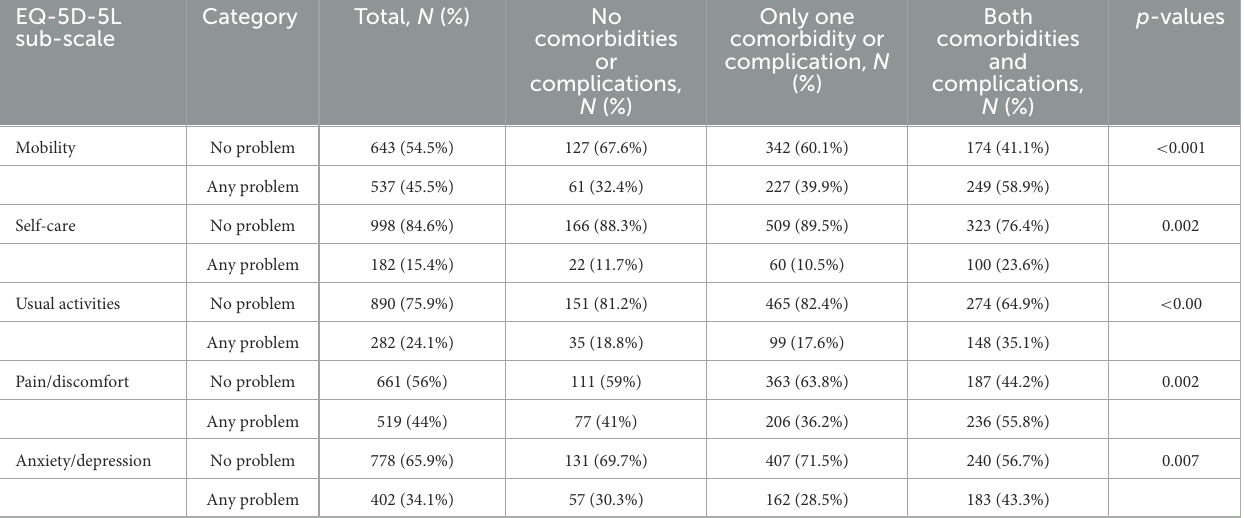
TABLE 4 EQ-5D-5L subscales categories by comorbidity and complication status. EQ-5D-5L